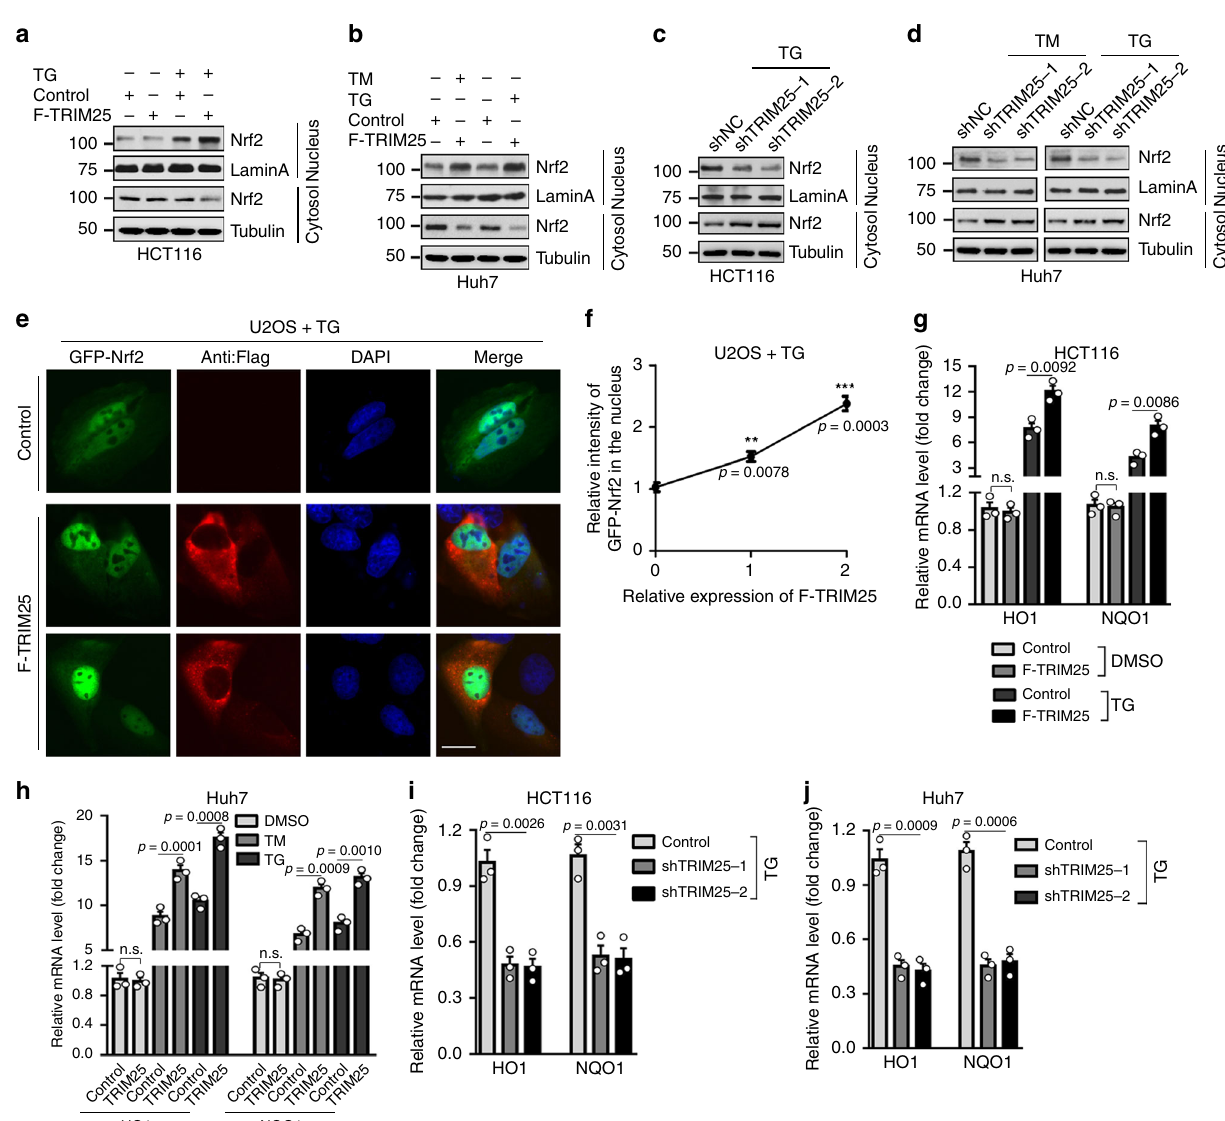
Fig. 4 TRIM25 activates Nrf2 via promoting its nuclear import. a , b Nuclear/cytosolic fractionation assay and western blot analysis of the level of Nrf2in control and F-TRIM25-expressing HCT116 cells ( a ), or these cells were treated with TG (1 μ M) for 12 h and the level of Nrf2 in the nuclear fraction was analyzed ( b ). LaminA is an internal control for nuclear fraction. c The level of Nrf2 in the nuclear fraction of HCT116 cells in control (shNC) or after stable knockdown of TRIM25, treated with TG (1 μ M) for 12 h. d The level of Nrf2 in the nuclear fraction of Huh7 cells in control (shNC) or after stable knockdown of TRIM25, treated with TM (5 μ g/ml) or TG (1 μ M) for 12 h. e , f Localization ( e ) and quanti fi cation ( f ) of GFP-Nrf2 (green) in control or F-TRIM25 (red) -expressing U2OS cells, treated with TG (1 μ M) for6h. The nucleus is labelled by DAPI (blue). Scale bar, 10 μ m. For quanti fi cation, 80 cells were for each group and the intensity of F-TRIM25 and GFP-Nrf2 in the nucleus was analyzed by Image J. And the relative intensity of GFP-Nrf2 in the nucleus of each group was relative to the control group. g Relative mRNA fold change of Nrf2 downstream genes: HO1, NQO1 in control and F-TRIM25-expressing HCT116 cells with stable knockdown of Nrf2, treated with or without TG (1 μ M) for 6 h. h Relative mRNA fold change of Nrf2 downstream genes: HO1, NQO1 in control and F-TRIM25-expressing Huh7 cells with stable knockdown of Nrf2, treated with DMSO, TM (5 μ g/ml) or TG (1 μ M) for 12 h. i , j Relative mRNA fold change of Nrf2 downstream genes HO1 and NQO1 in HCT116 ( i ) and Huh7 ( j ) cells with control (shNC) or TRIM25 stably knockdown, treated with TG (1 μ M) for 12 h. For f – j , data represent the mean ± SEM ( n = 3). Statistical signi fi cance was assessed using two-tailed Student ’ s t-tests. ** P < 0.01, *** P < 0.001, n.s. not signi fi